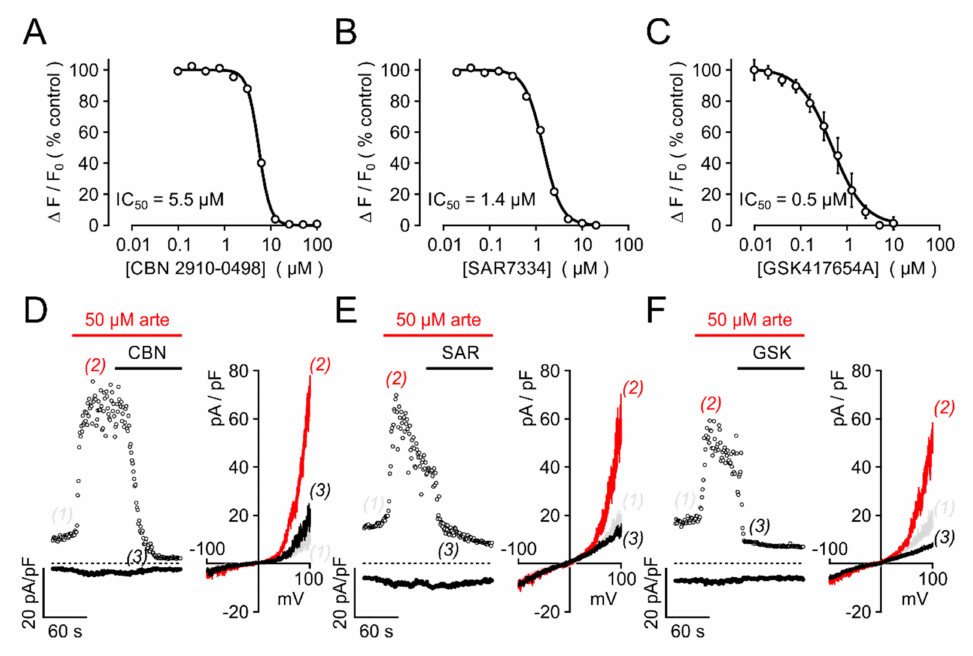
Figure 9. Artemisinin-induced ionic currents in HEK293 cells and in PC12 cells are sensitive to established TRPC3 inhibitors. ( A – C ) Serial dilutions of the indicated inhibitors were applied to HEK TRPC3-YFP cells at the indicated final concentrations for 5 min, and responses to acute challenge with 50 µ M artemisinin were measured in fluo-4-loaded HEK TRPC3-YFP cell suspensions. Concentration–response curves were normalized to responses measured without an inhibitor (controls), and IC 50 values were obtained by fitting a four-parameter Hill equation to the data. Data are compiled from 4–6 independent experiments performed in duplicate, each. ( D – F ) Ionic currents in PC12 cells were induced by 50 µ M artemisinin and recorded as in Figure 7C, but with inhibitors CBN 2910-0948 (CBN, 10 µ M; D ), SAR7334 (SAR, 5 µ M; E ), or GSK417654A (GSK, 5 µ M; F ) added in the continuous presence of artemisinin. Note the markedly accelerated current decay during application of the inhibitors (left panels). Corresponding I / V curves taken at the indicated time points are plotted (right